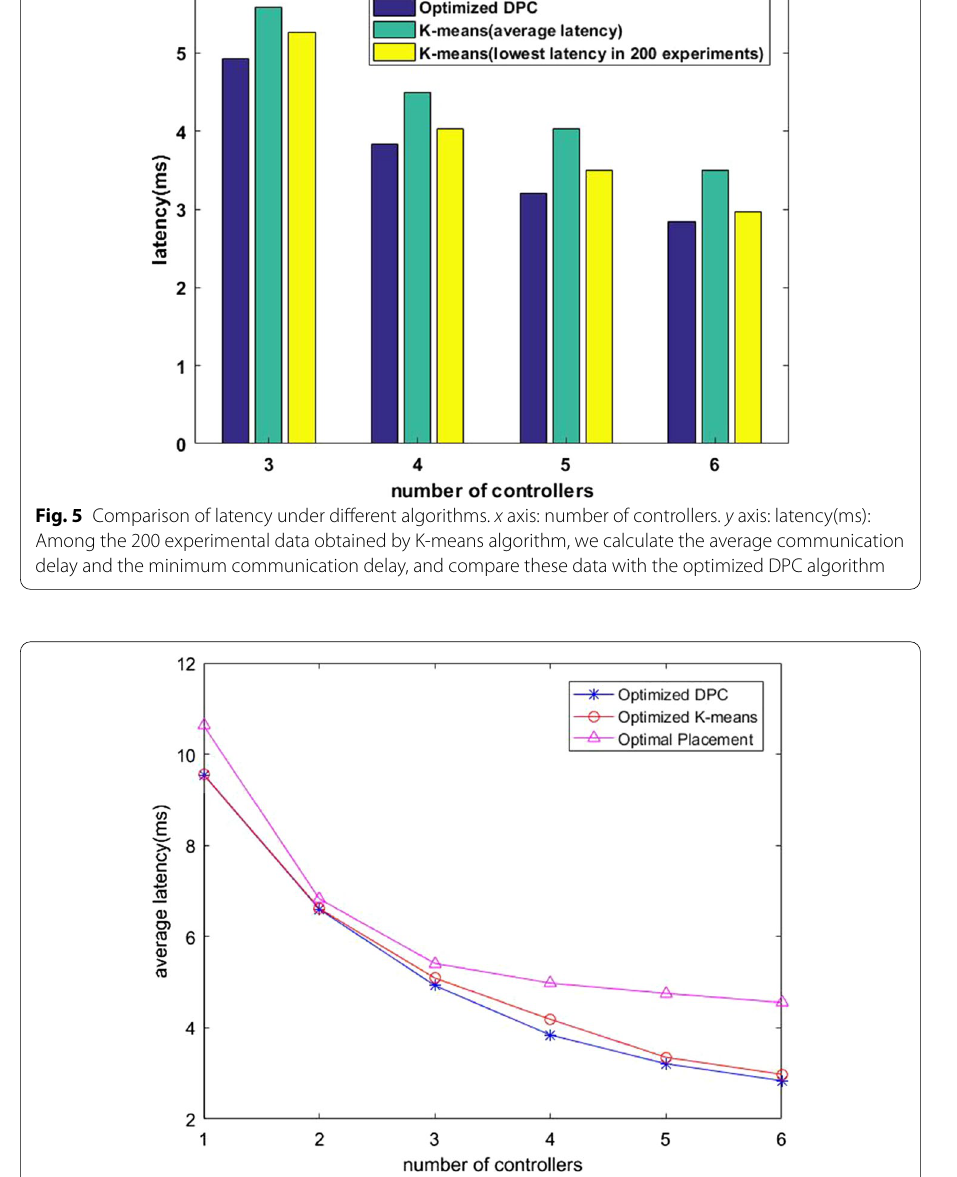
Fig. 6 Average latency of three algorithms with different controller numbers. x axis: number of controllers. y axis: average latency (ms): The figure shows that the average communication delay on the OS3E topology is calculated by the optimized DPC algorithm, the optimized k-means algorithm and the optimal placement algorithm respectively. And then, the data values we calculated by these algorithms are compared with each